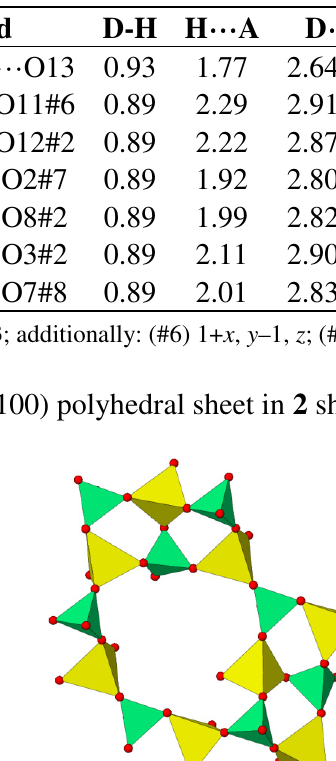
Table 4. Hydrogen bond geometries (Å and ° ) in 2 .